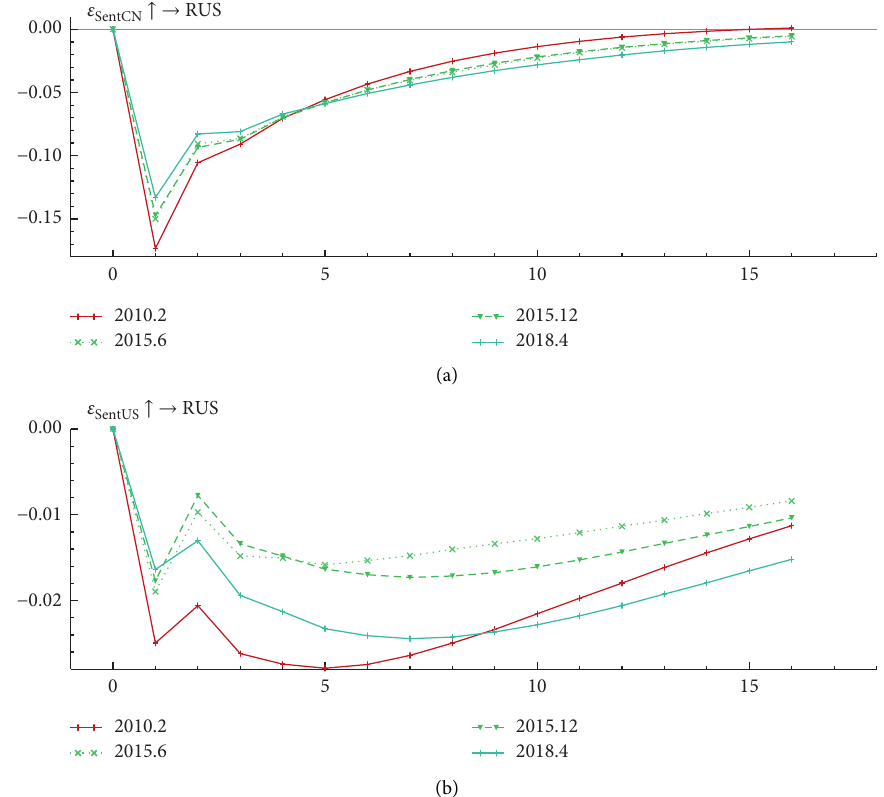
Figure 11: The impulse response of the US stock market return at different time points.